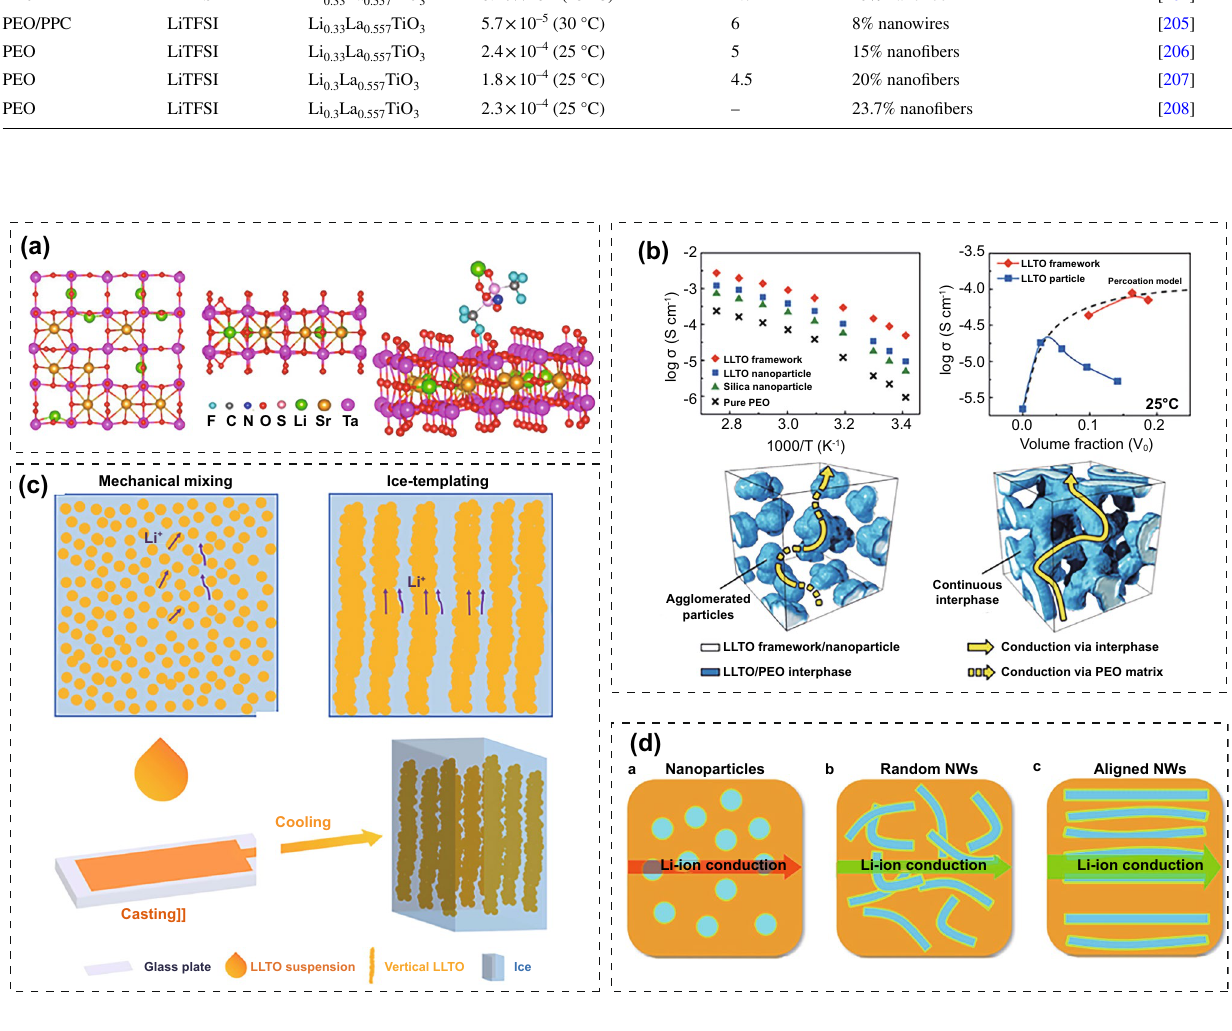
Fig. 12 a Structure of the LSTZ and LiTFSI adsorbed on the surface of the LSTZ [199]. Copyright 2019, Proceedings of the National Academy of Sciences. b Ionic conductivity and percolation model of LLTO networks and LLTO nanoparticles [200]. Copyright 2018, John Wiley and Sons. c Schematic diagram of Li + ion conduction in continuous network and randomly scattered LLTO [201]. Copyright 2020, Elsevier. d Sche- matic diagram of Li + ion conduction in randomly scattered and well-aligned nanowires [203]. Copyright 2017, Springer